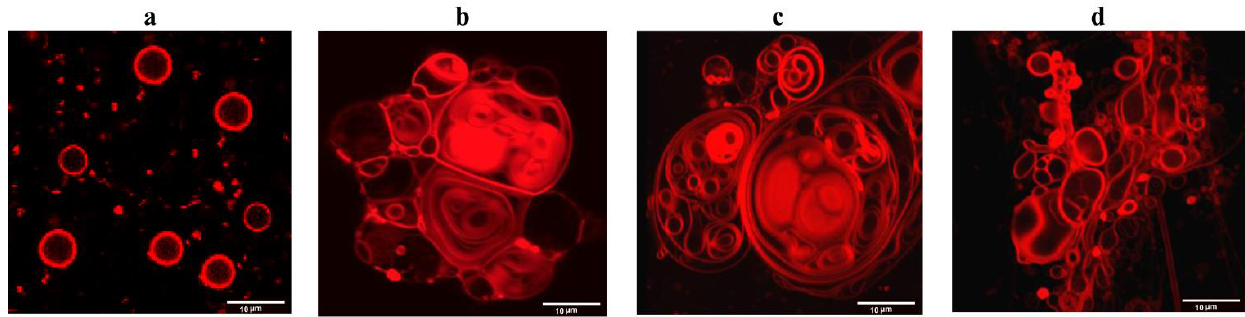
Figure 4. Fluorescence micrographs of giant unilamellar vesicles made from POPC/SM/CHOL (60/20/20 mol%) and 1 mol% of fluorescent lipid probe Rh-DPPE in the absence of any modifiers ( a ), and in the presence of 10% of PEG-8000 ( b ), 50 µM of FP-SARS-CoV-2 ( c ), and 200 µM of FP-MERS-CoV ( d ).